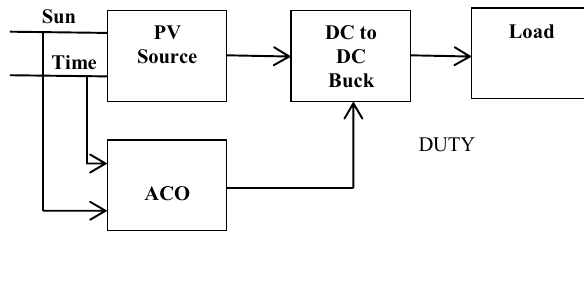
Fig. 2 Block diagram of the proposed system [25]